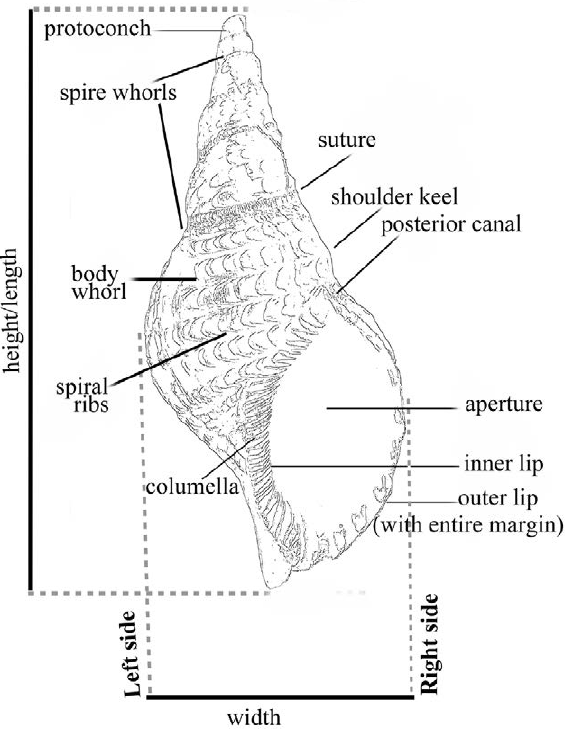
Figure 3. Generalised diagram of a gastropod